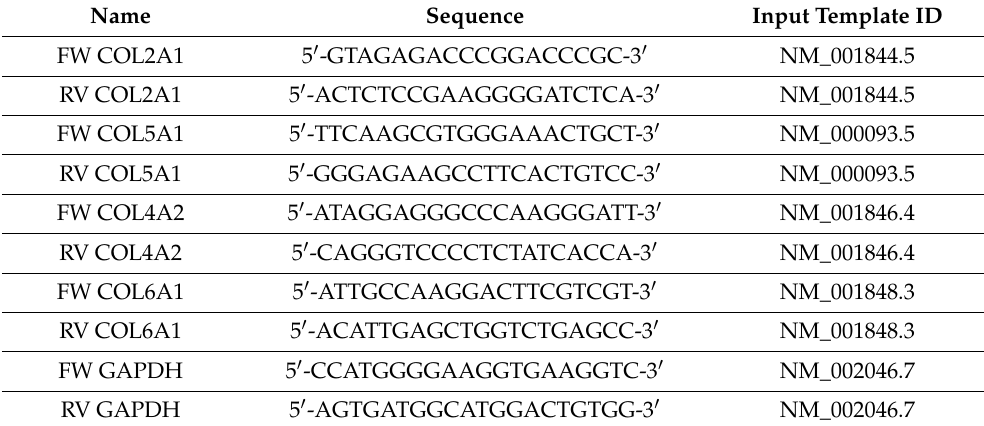
Table 1. Primers used for real time QPCR